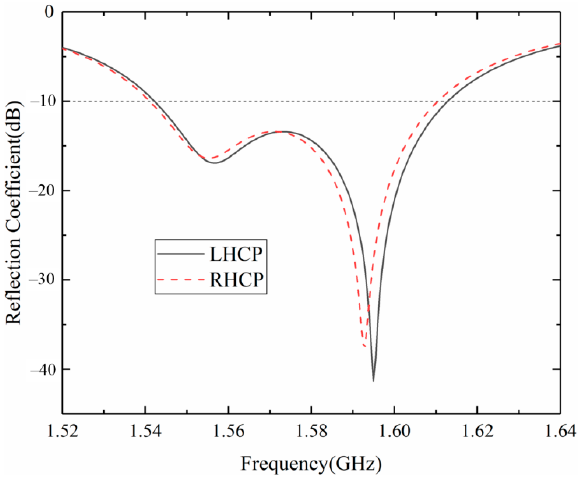
Figure 4. Simulated reflection coefficient of the NDCPPA model’s element.